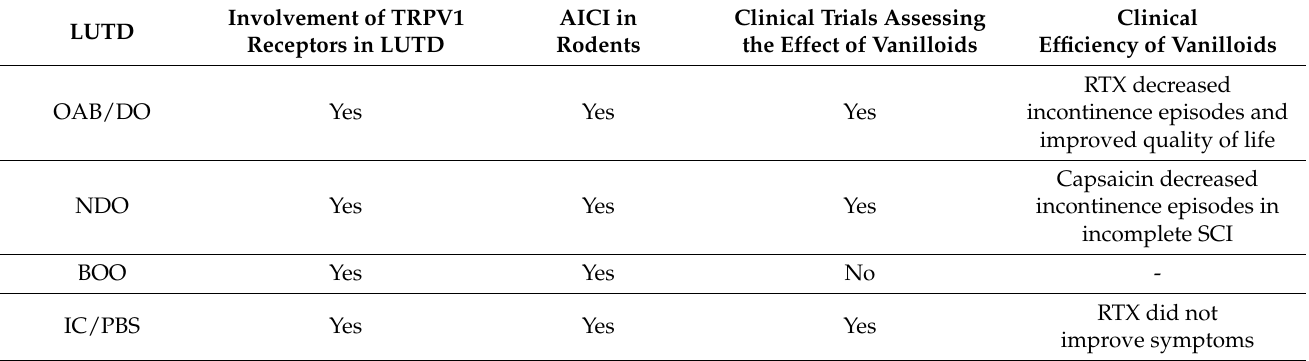
Table 1. Summary of the data regarding (i) the involvement of TRPV1 sensory fibers in the pathophys- iology of lower urinary tract dysfunctions (LUTD), (ii) the relevance of acute intravesical capsaicin instillation (AICI) in rodents to mimic the condition, (iii) clinical trials assessing the effect of vanilloids for the treatment of the condition and (iv) main outcomes of the clinical trials. RTX—resiniferatoxin, SCI—spinal cord